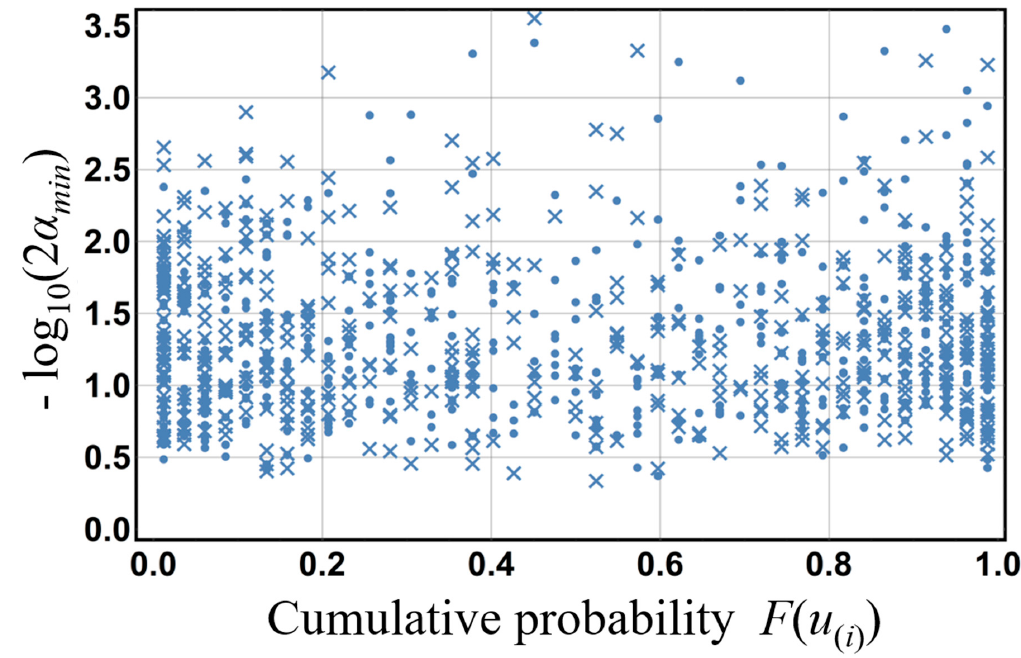
Figure 4. Relation between − log 10 (2 α min ) and cumulative probability F ( u i ) of i th-order statistics u i yielding probability α min .